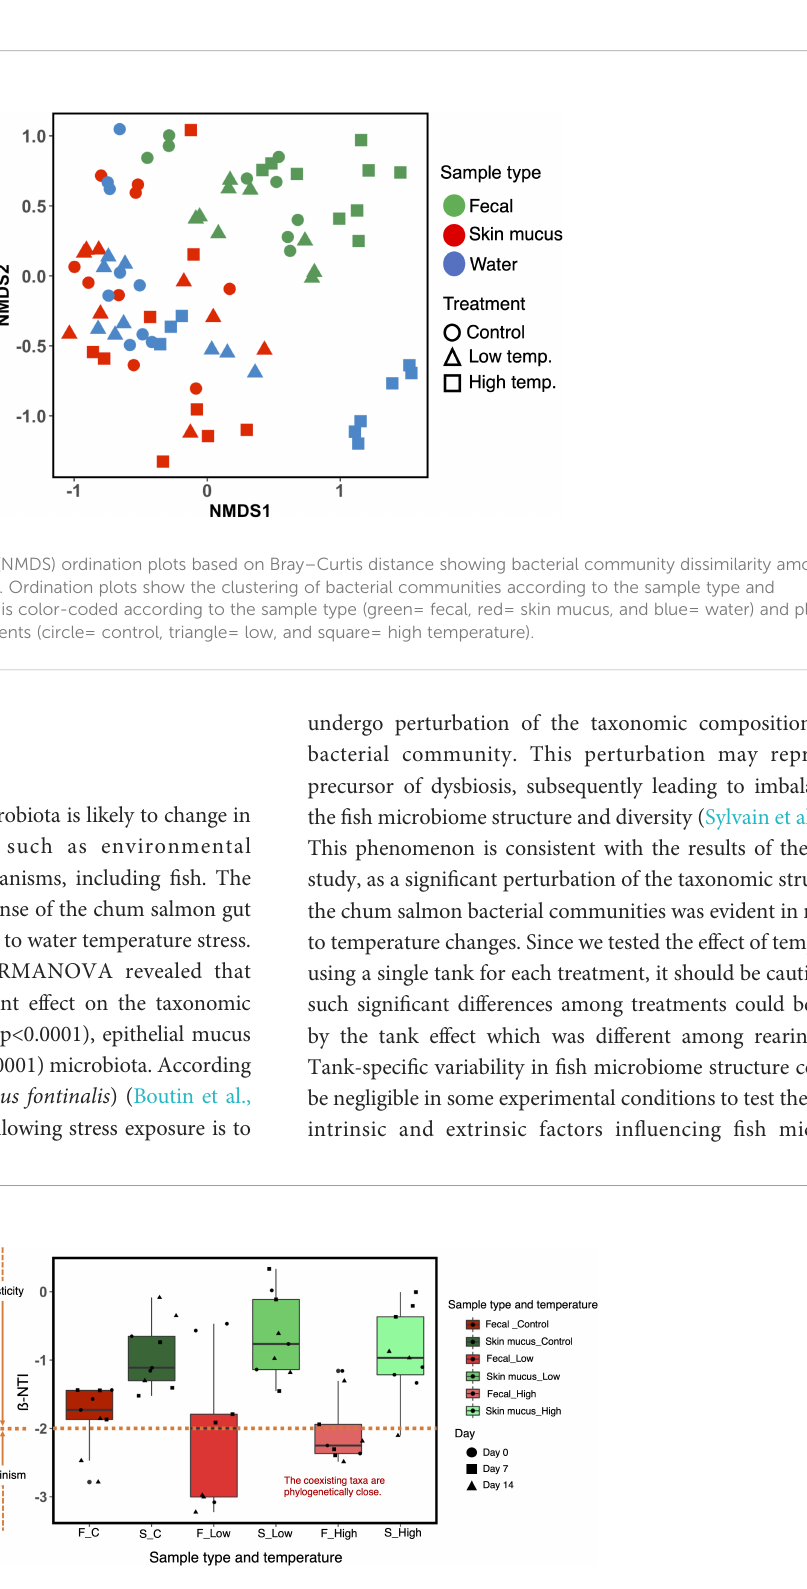
FIGURE 7 ß-NTI values for the comparison of bacterial community assembly processes in the chum salmon gut and skin microbiota under each temperature treatment at Day 0, Day 7 and Day 14. ß-NTI>2 and ß-NTI<-2 indicate heterogeneous and homogeneous selection, respectively. ß- NTI<2 indicates comparisons that are not signi fi cantly different from the null model and suggests stochastic community